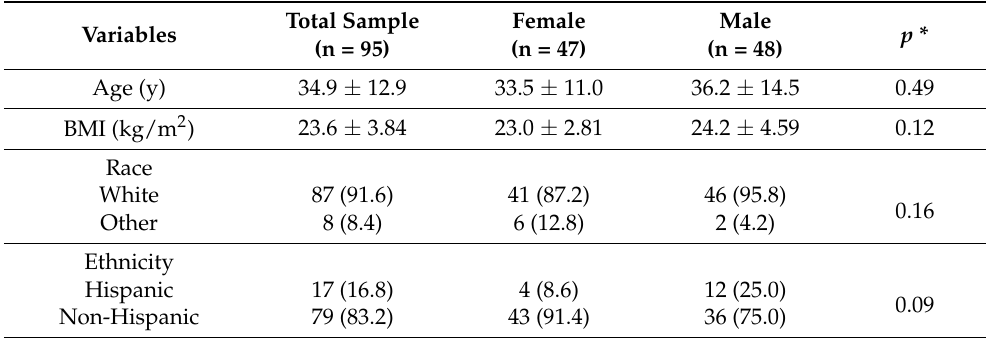
Table 1. Participant characteristics of endurance